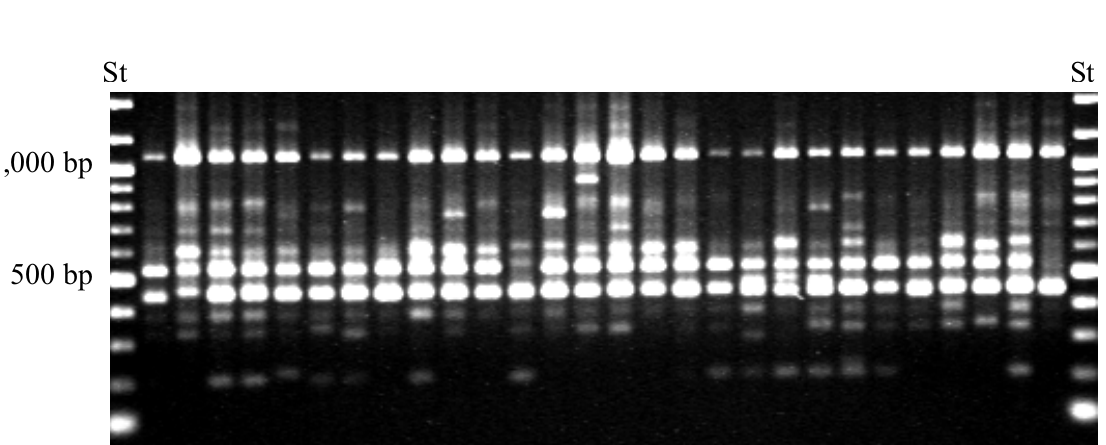
Fig. 1. Banding patterns obtained using a single 10-mer primer to amplify the DNA from 28 isolates of Phellinus sp. (St = standard). Common bands as well as polymorphic markers are obvious.